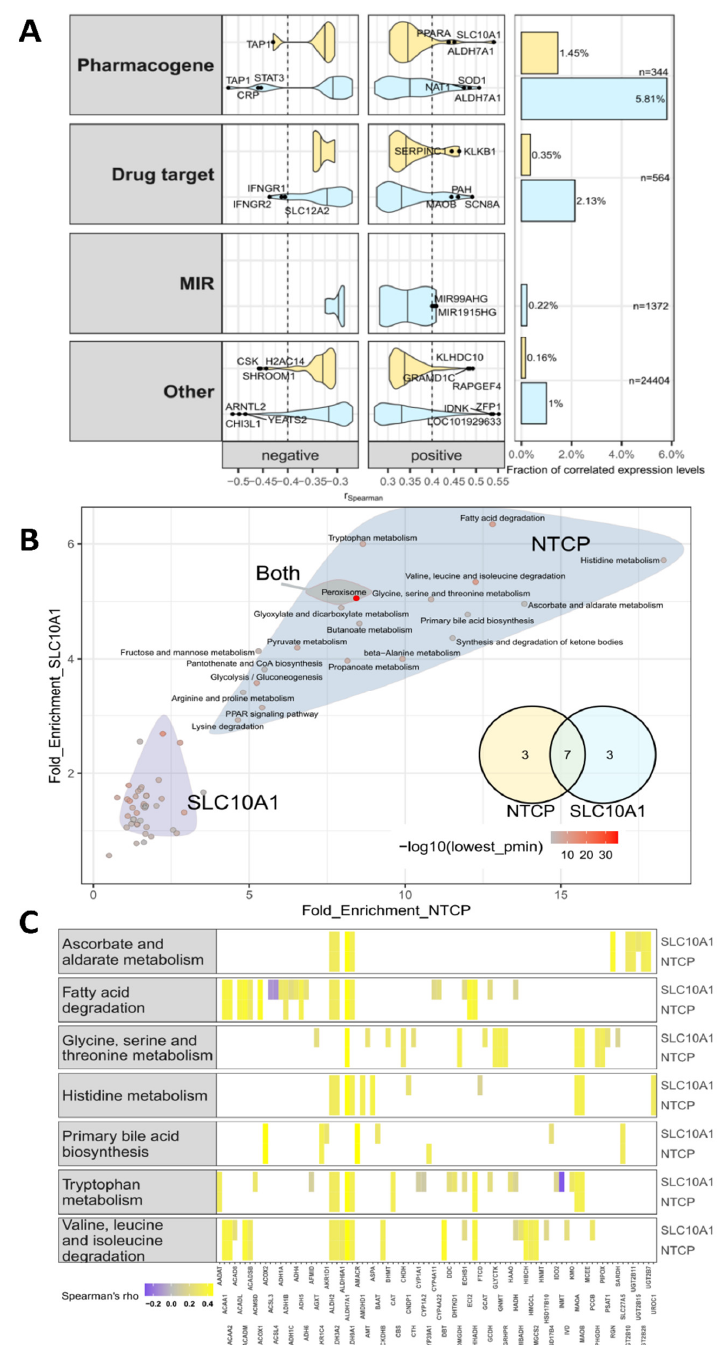
Figure 6. Genome-wide expression correlation analysis and gene set enrichment analysis. ( A ) Violin plots showing correlation results between genome-wide expression of the selected gene groups and SLC10A1 expression levels as determined by qPCR (light blue) and NTCP protein levels (yellow), respectively. Top correlated genes (r S ≤ −0.4 or r S ≥ 0.4) are labeled with gene names. Barplots of the right figure are showing the percentage of significantly correlated genes (adjusted p < 0.05 and r S